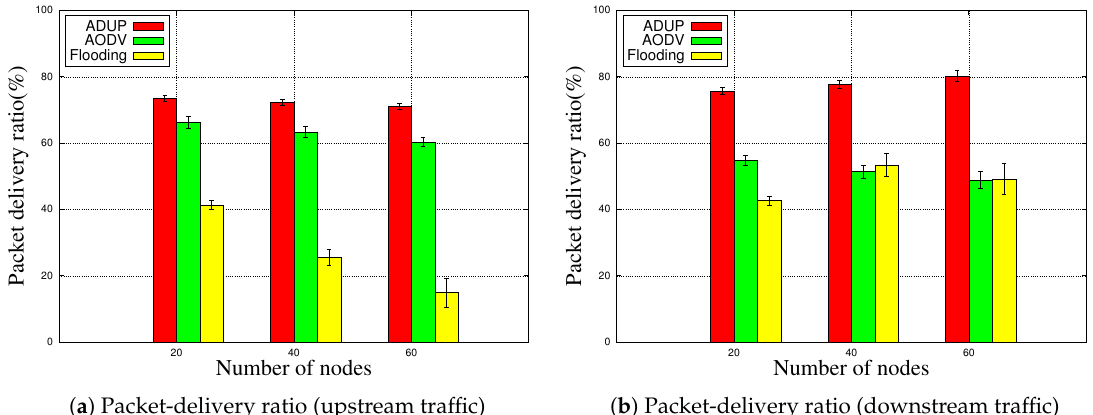
Figure 6. Packet delivery